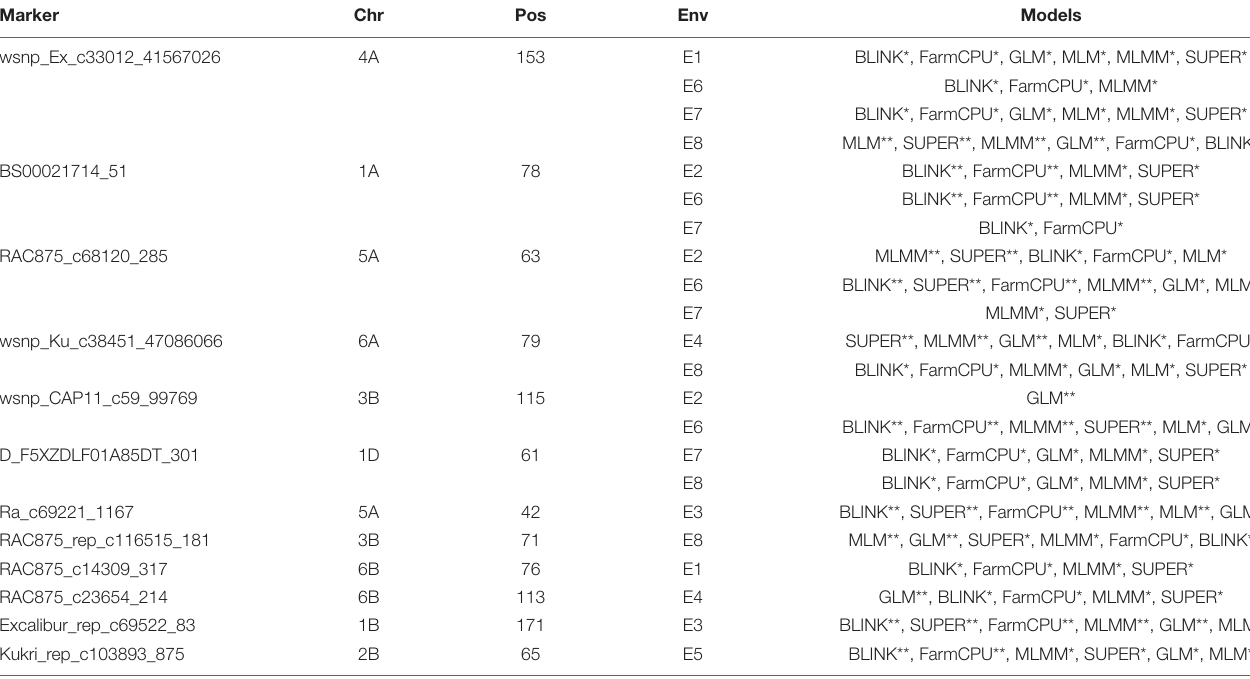
FIGURE 2 | A scatter plot for r 2 values of pairwise SNPs showing genome-wide linkage disequilibrium (LD) decay. The blue curve line is the smoothing spline regression model fitted to LD decay. The horizontal red line is the standard critical r 2 value of the genome ( r 2 = 0.3), and the vertical yellow line is the genetic distance (1.6 cM) at the intersect between the standard critical and the LD decay curve. The vertical green line is the genetic distance (2.0 cM) at which the LD half-decay ( r 2 = 0.23, the vertical orange line) intersect with the LD decay curve. TABLE 2 | Summary of GWAS results for significant SNP markers for Septoria tritici blotch. Marker Chr Pos Env